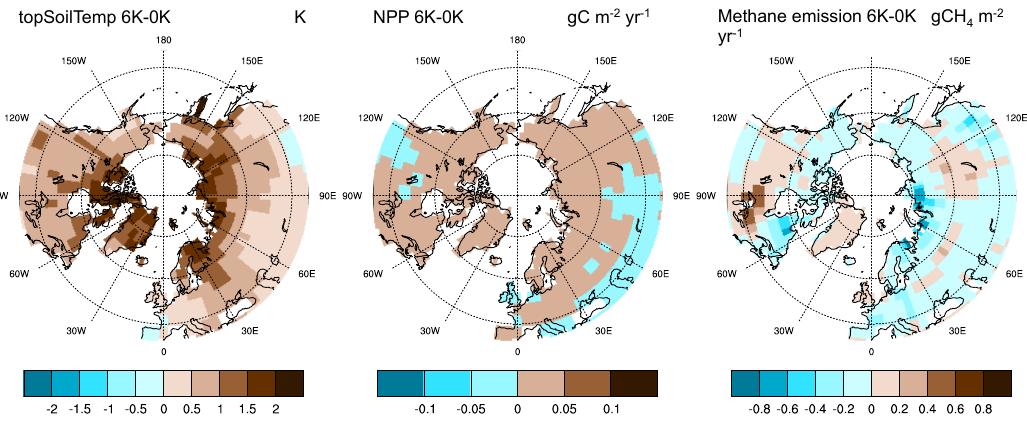
Fig. 2. Left and middle panel: changes of variables simulated by the MPI-ESM and used here for driving the peatBALANCE model. Shown are 10-yr averages for pre-industrial (0yrBP) minus 6000yrBP. Annual temperatures of the uppermost soil layer (Kelvin, left). NPP Fig. 2. (gCm − 2 yr − 1 , middle). Right panel: modelled CH 4 emissions (gCH 4 m − 2 yr − 1 ) for pre-industrial (0yr BP) minus 6000yrBP.